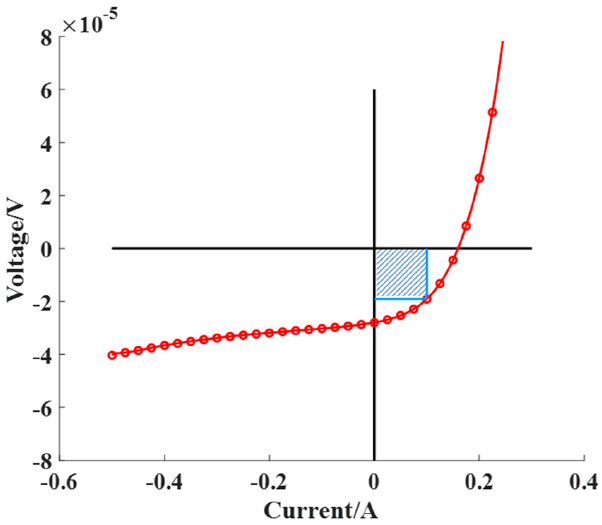
Figure 6. The maximum power generated in this specific setting was 1.91 µW with a load resistance of 5250 Ω .